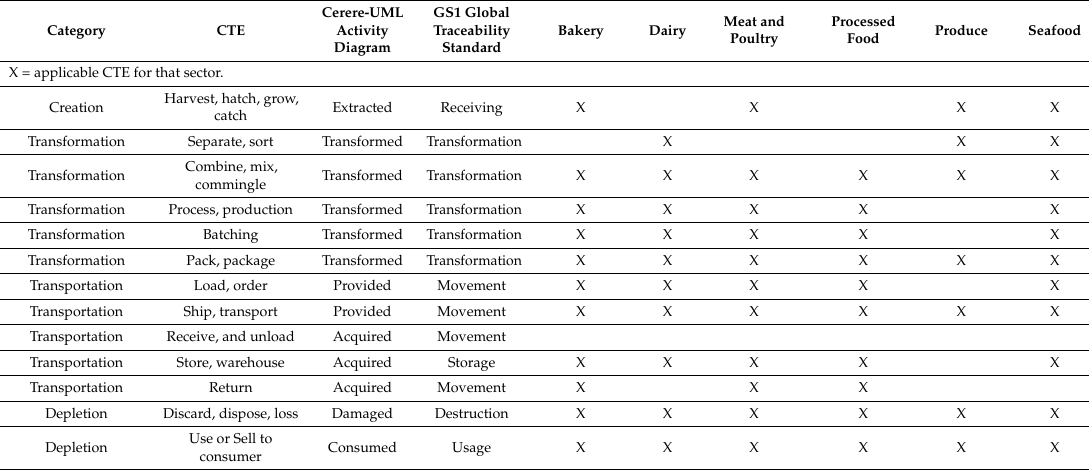
Table 3. Comparison of consolidated CTE for the different supply chain families [27] with Cerere [23] and GS1 methodology.